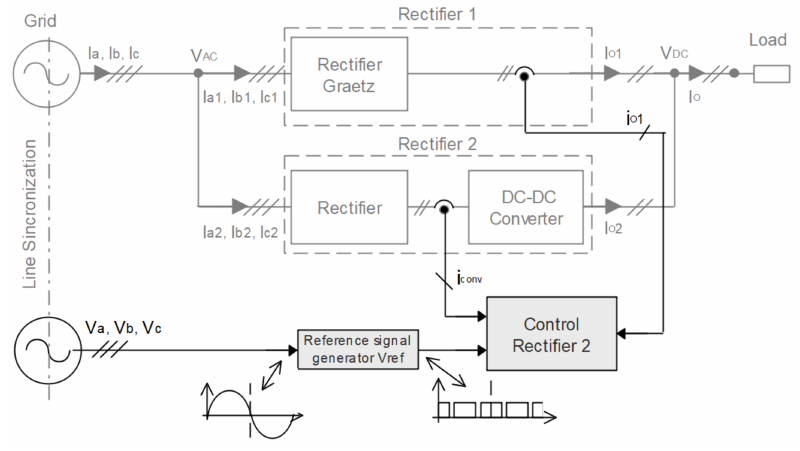
Figure 28. Configuration of electrical circuit applied in HTR with multilevel current.